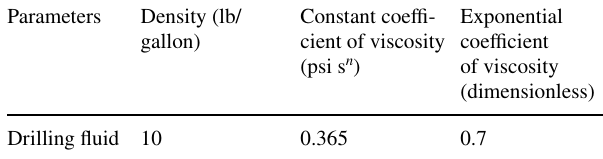
Table 2 Rheological parameters of drilling mud